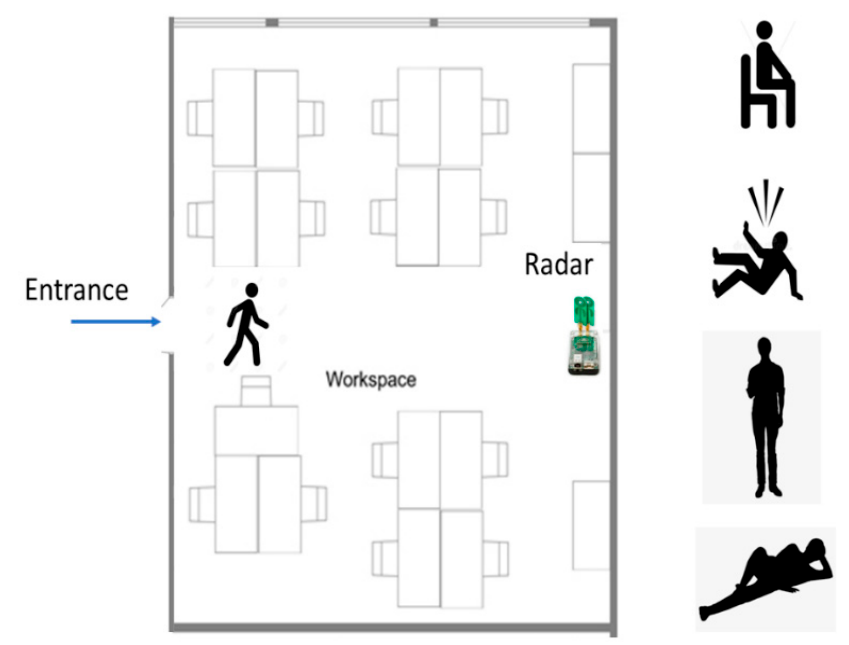
Figure 2. Experimental setup at the university office room.